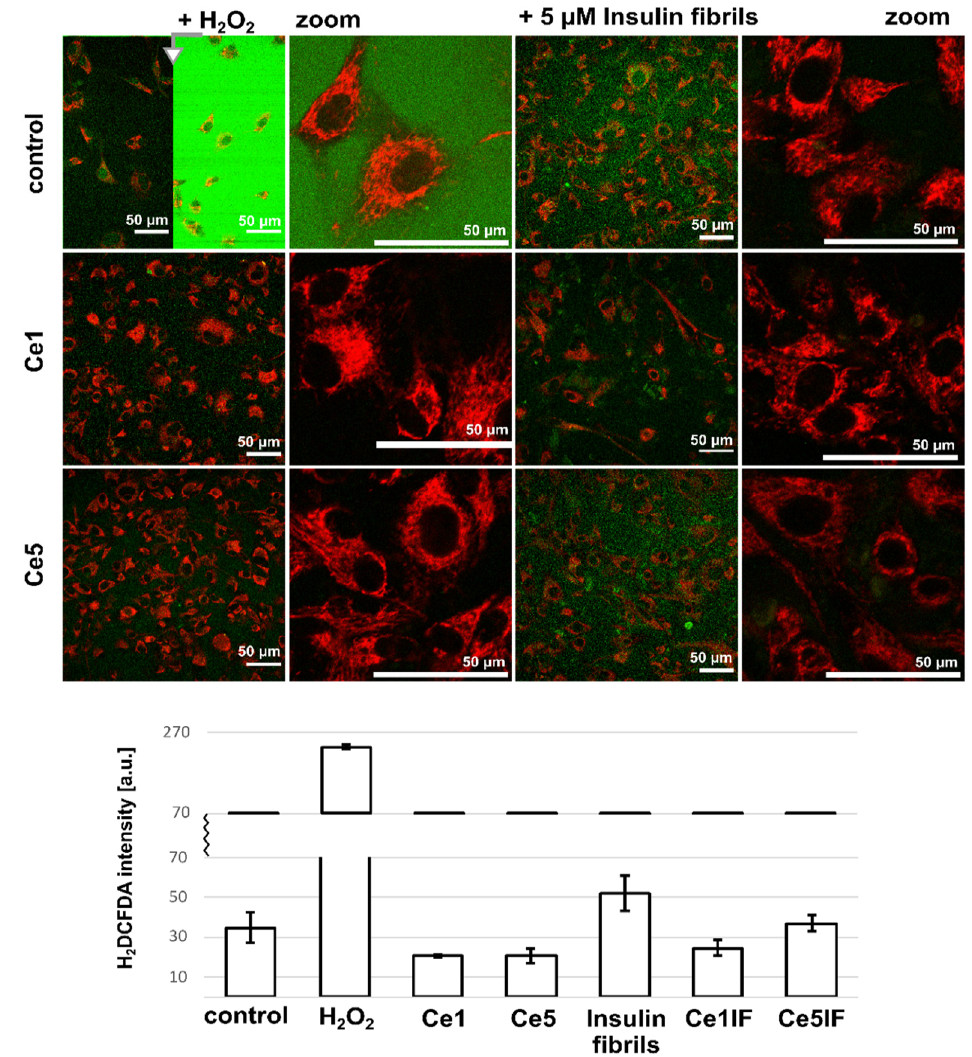
Figure 8. Representative fluorescence images of H 2 DCFDA (green) and TMRM (red, in mitochondria) in U87 MG cells. The cells were subjected for 24 h to Ce1 and Ce5 nanoparticles at 150 µ g/mL and with 5 μ M insulin fibrils. ROS production was induced with 100 μ M H 2 O 2 . Fluorescence intensity levels of H 2 DCFDA were plotted into the histograms (under fluorescence images). Fluorescence images in the absence of TMRM are depicted in Figure S7.